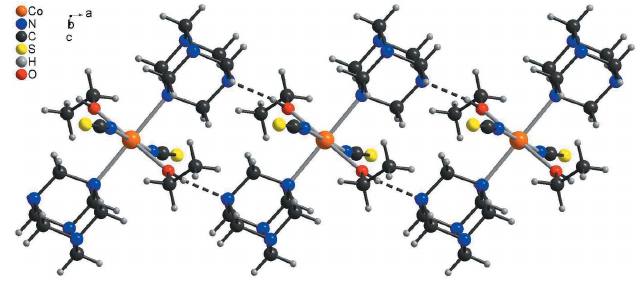
Figure 3 Crystal structure of compound 1 with a view of a chain formed by intermolecular O—H (cid:2)(cid:2)(cid:2) N hydrogen bonding along the crystallographic a -axis. Intermolecular hydrogen bonding is shown as dashed lines.